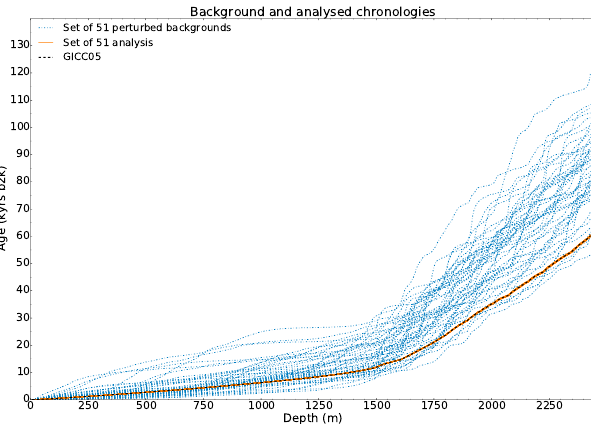
Figure 1. Twin experiments: 51 perturbed background chronolo- gies (dashed blue lines) and the corresponding 51 analysed chronologies, i.e. output chronologies from Datice (orange lines). The GICC05 chronology (the “truth” in our twin experiments) is represented by the dashed black line for